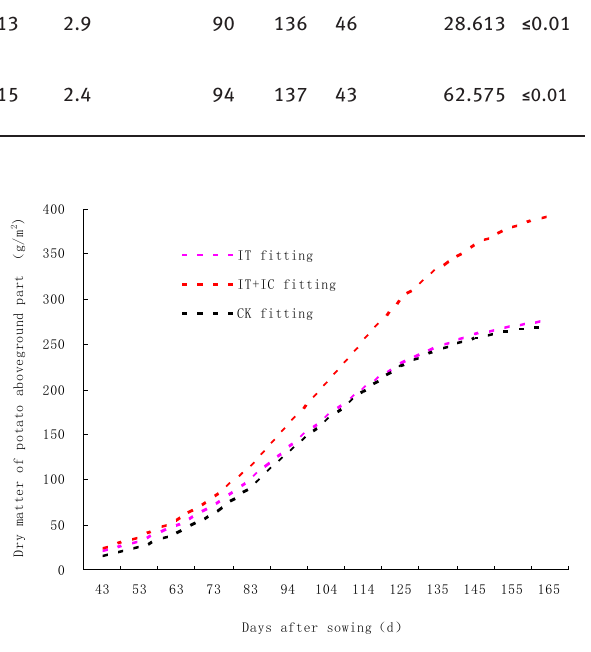
Figure 4: Dynamic simulation curve of dry matter accumulation for potato aboveground part in different